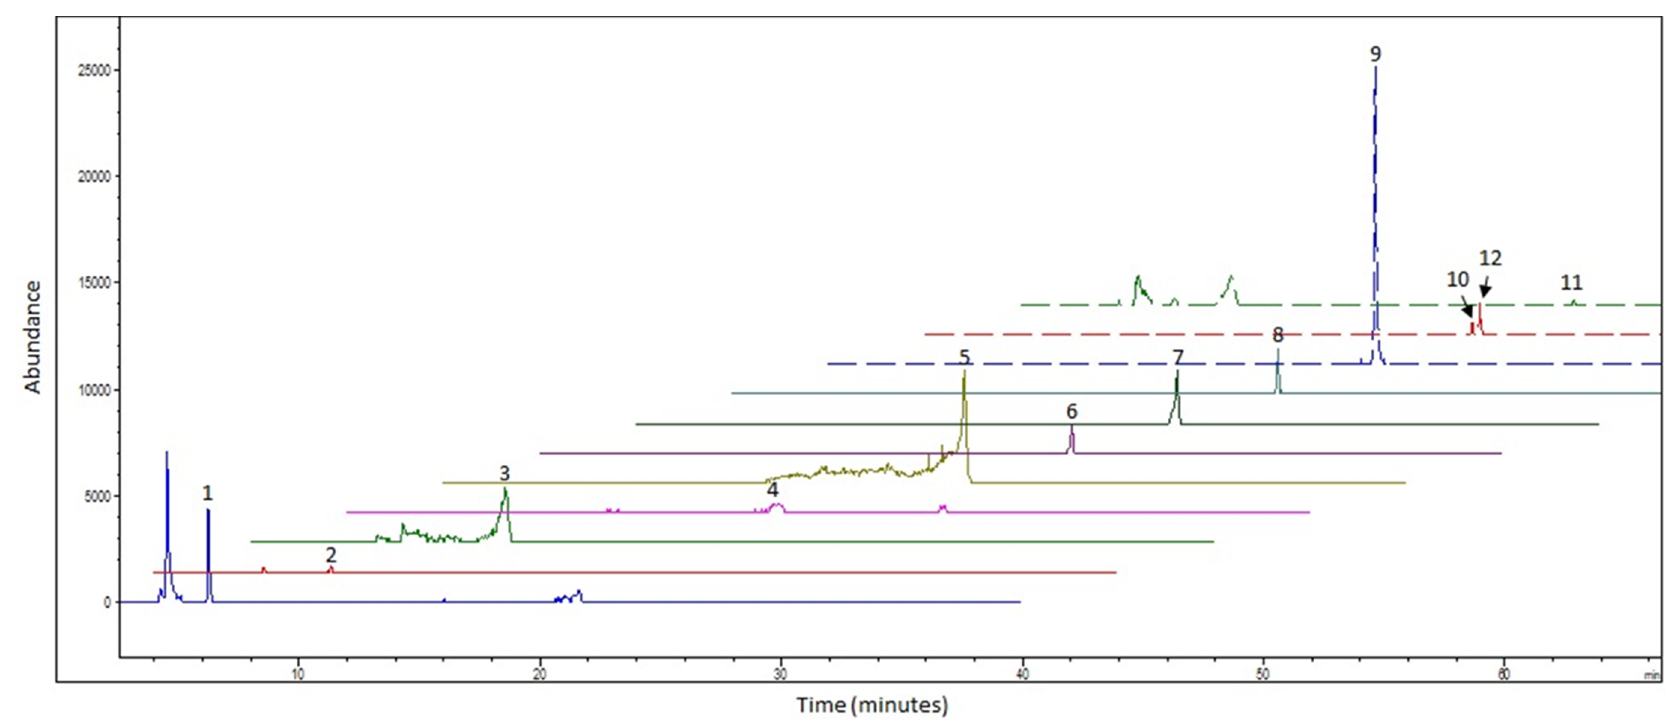
Figure 1. Example LC-MS extracted ion chromatogram of glucosinolates from steamed-pureed turnips. Peak identity: (1) progoitrin; (2) glucoalyssin; (3) gluconapin; (4) 4-hydroxy-glucobrassicin; (5) glucobrassicanapin; (6) glucoerucin; (7) glucobrassicin; (8) glucoberteroin; (9) gluconasturtiin; (10) 4-methoxyglucobrassicin; (11) Gluconapoleiferin and (12) Neoglucobrassicin, corresponding with glucosinolates listed in Table 3 and their extracted mass ion.